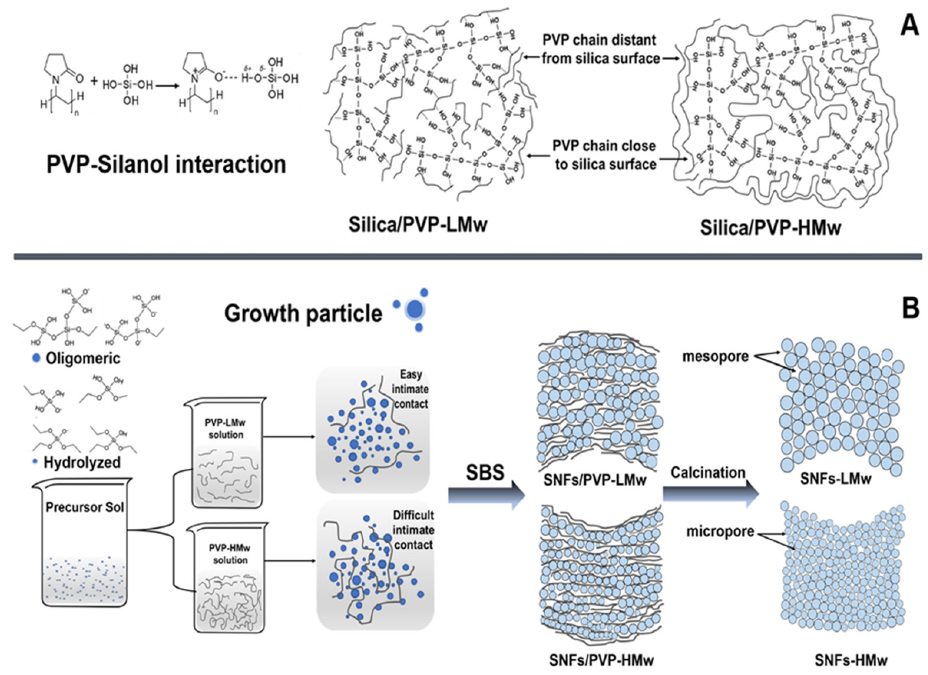
Scheme 1. ( A ) Interaction between silanol groups and PVP unit and chain, and ( B ) schematic illustration of PVP chain and silica particle in precursor solution, as-spun fiber and pores size after calcination process.